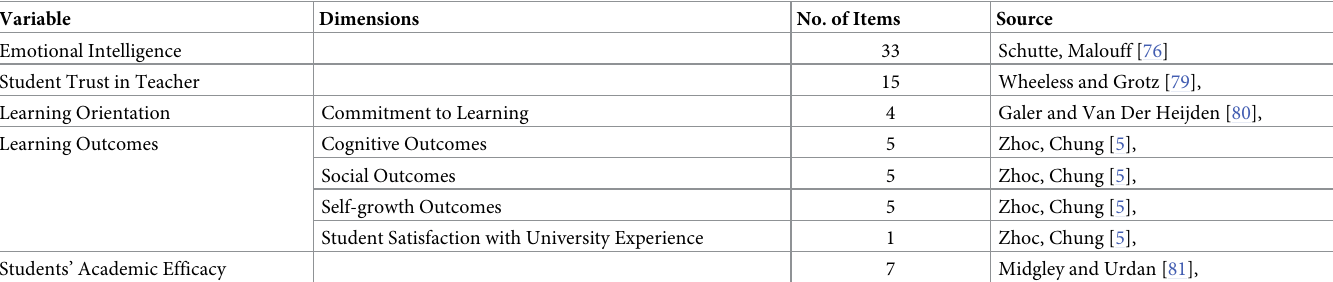
Table 3. Source of measurement